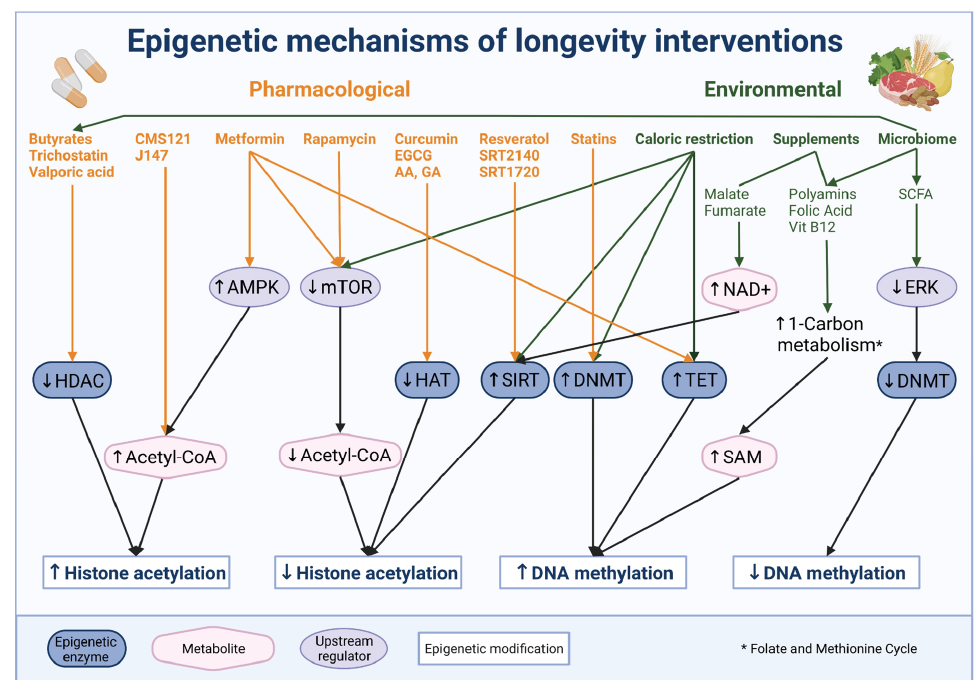
Figure 4. Pharmacological and environmental longevity interventions impacting epigenetic mecha- nisms. A number of pharmacological substances mediate their beneficial effects on life span via epigenetic enzymes or upstream regulators that influence levels of crucial metabolites. Caloric re- striction was demonstrated to positively affect life span acting via similar mechanisms, while some amino acids and vitamins support the generation of metabolites for methylation and acetylation.